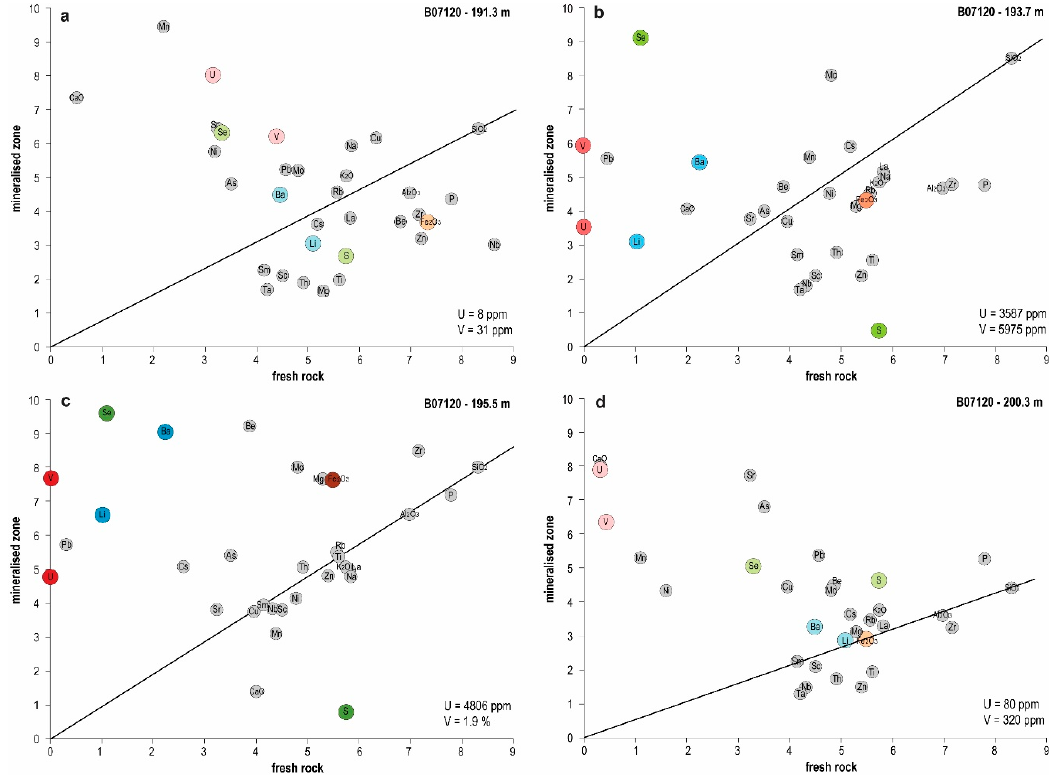
Figure 12. Isocon plots showing element variation across the mineralized zone of drill core B07120, ( a ) calcite-cemented interval 2 m above the mineralization shown by CaO-enrichment compared to reference sample; ( b ) mineralized zone showing enrichment of Li, Ba and Se beside U-V mineralization and depletion of S; ( c ) mineralized zone with high V concentration showing enrichment of Li, Ba, Se, Be and Fe, Mg and depletion of S; ( d ) calcite-cemented interval 5 m below the mineralization showing elevated U-V.